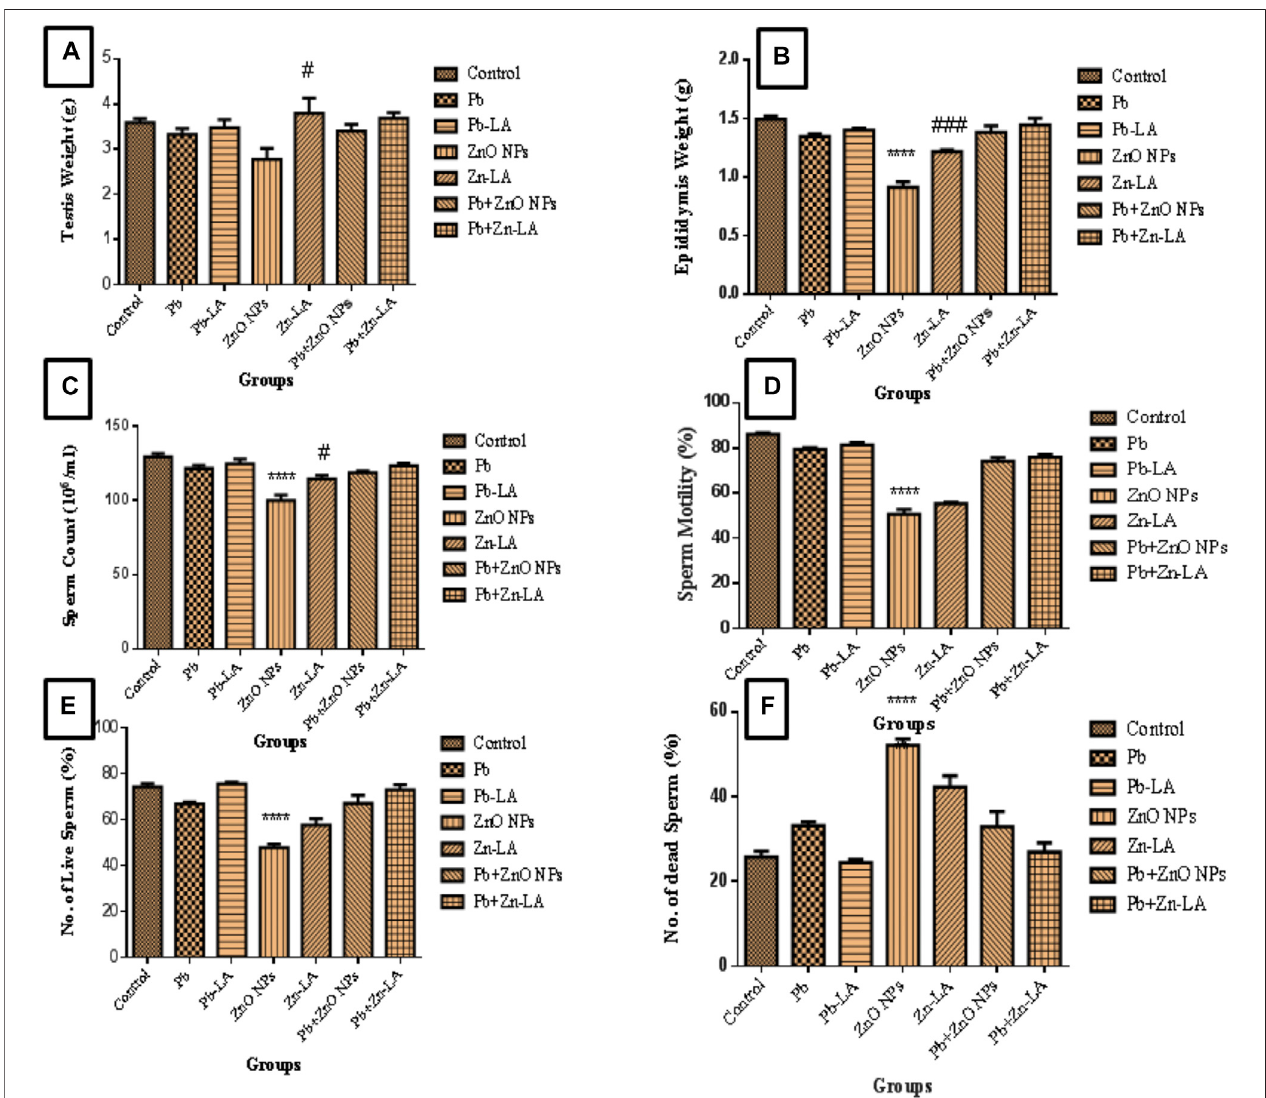
FIGURE5| Effectontheweightof (A) testes, (B) epididymis, (C) spermcount, (D) spermmotility, (E) anumberoflivesperms(%),and (F) anumberofdeadsperms (mean ± SEM). Statistical signi fi cance is represented as **** p < 0.0001 as compared with control and # p < 0.05, ### p < 0.001 as compared with zinc oxide nanoparticles alone